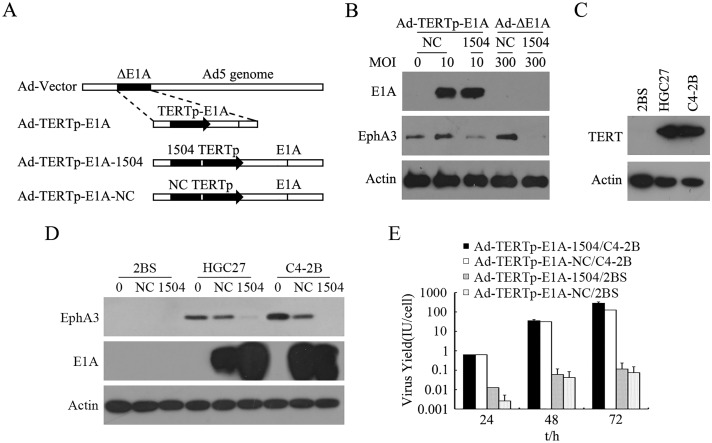
Traits of Ad-TERTp-E1A-1504 and Ad-TERTp-E1A-NC.A: illustration of E1A-completent adenoviruses. 1504-siRNA was incorporated into TERTp driving the E1A adenovirus vector, and Ad-TERTp-E1A-NC was produced by replacing 1504-siRNA with a negative control sequence. B: EphA3 and E1A expression after viral infection of C4-2B. C: TERT expression in 3 cells lines (Western blot) D: EphA3 and E1A expression viral infection of C4-2B, HGC27, and 2BS. E: Replication of CRAds in TERT-positive tumor cell lines and TERT-negative cells. Viral yield in C4-2B increased significantly with greater exposure and viral yield in 2BS cells increased slightly 24 to 72 h after infection.